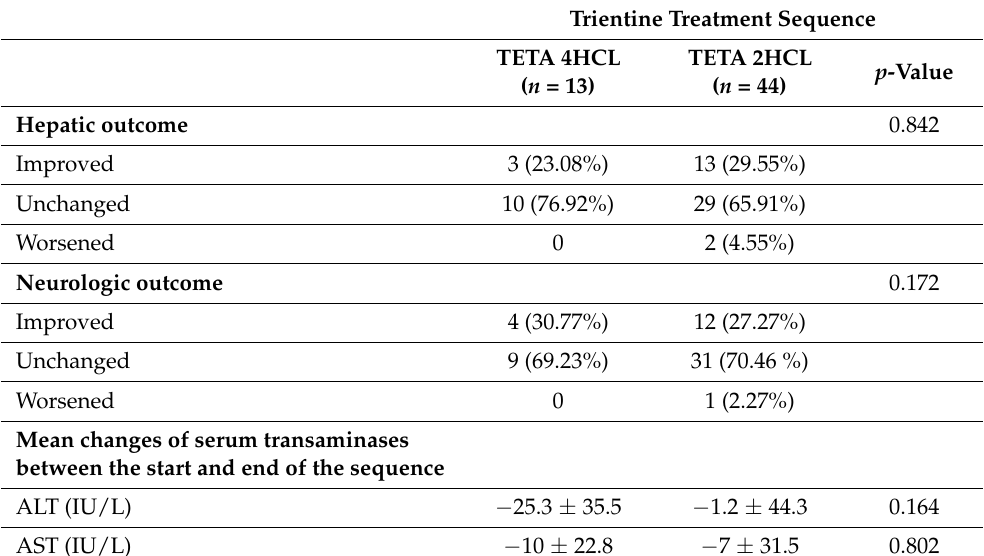
Table 2. Hepatic and neurologic evolution in all patients.